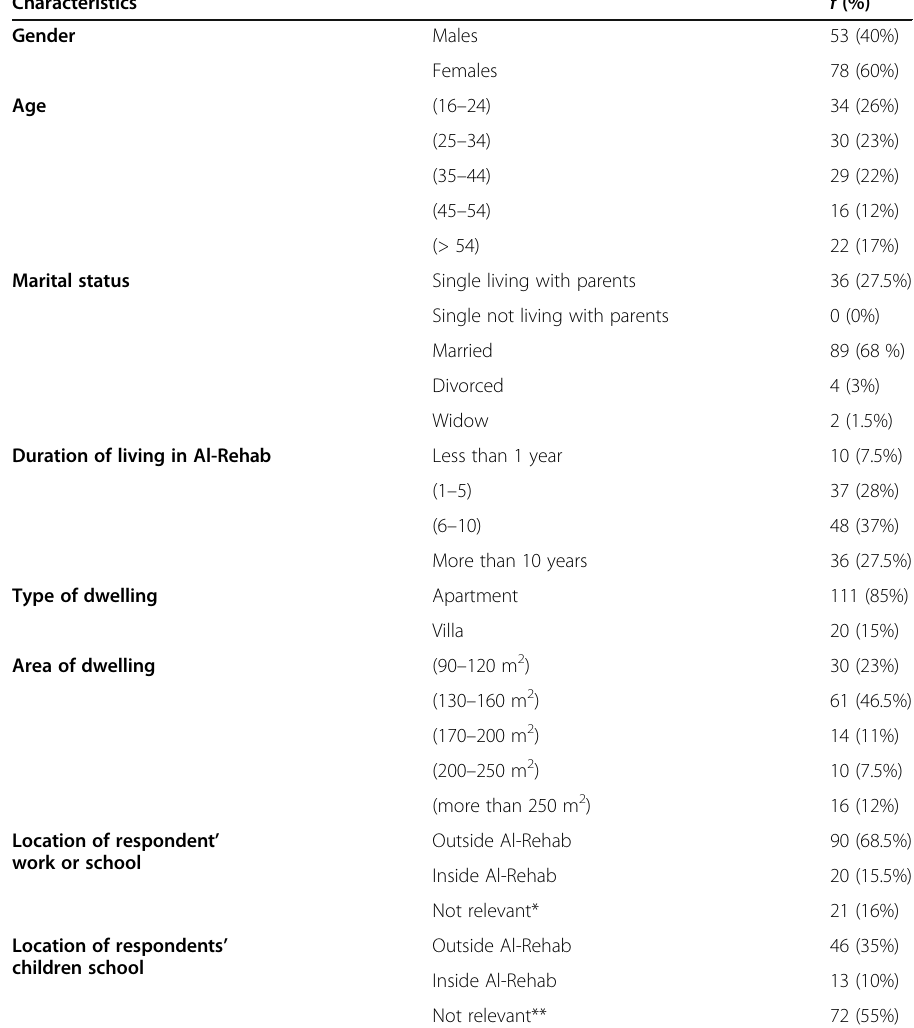
Table 2 Main demographic characteristics of the respondents ( n = 131)